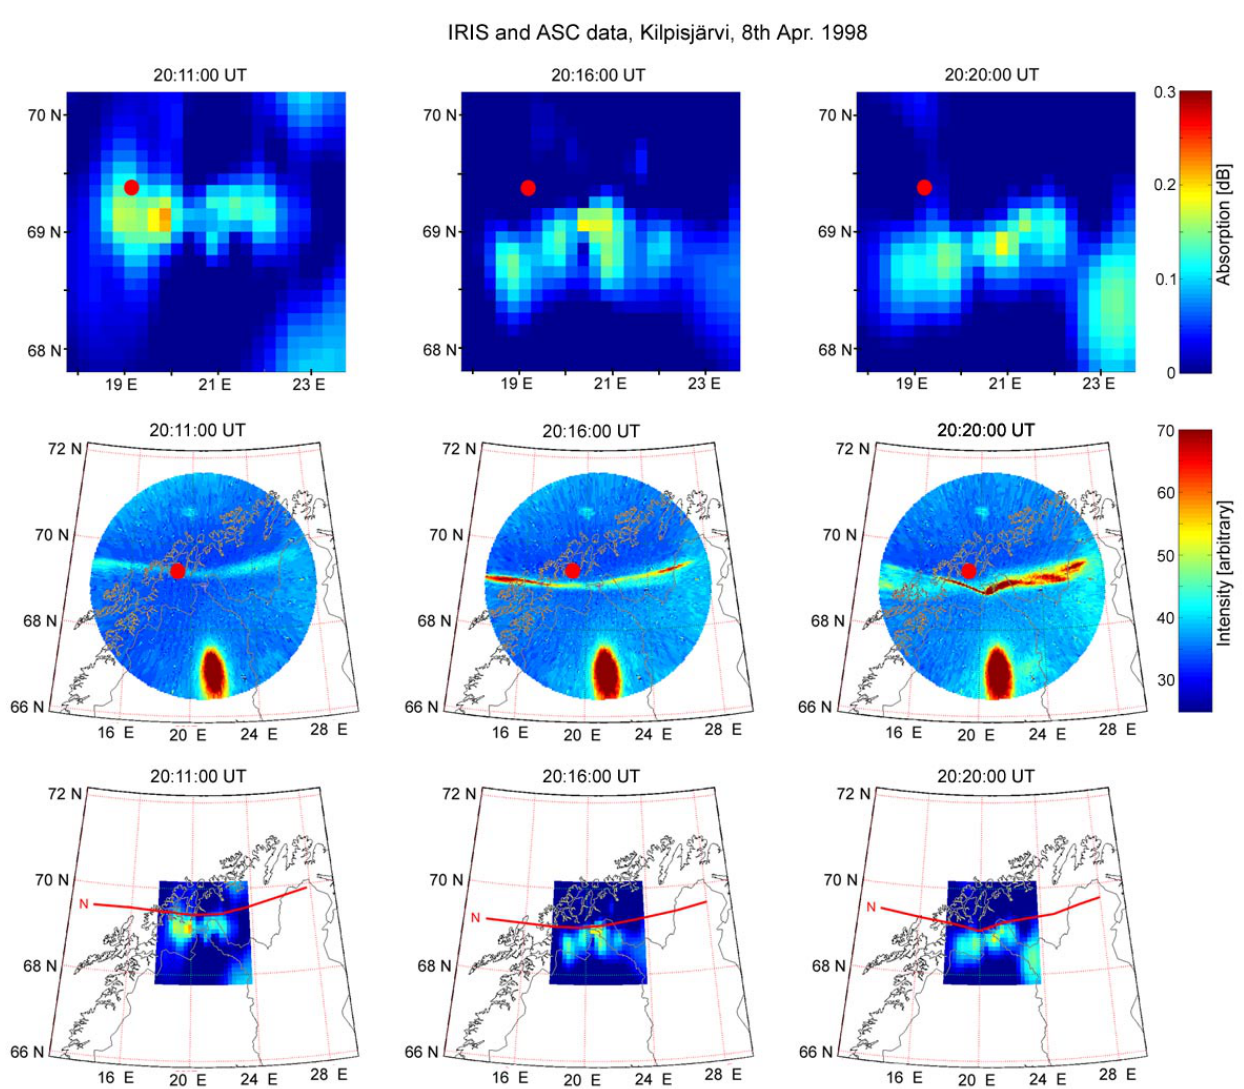
Fig. 5. Absorption, optical and combined data from three times for Event 2 on 8 April 1998. The top panel shows the colour coded absorption from IRIS mapped to the longitude-latitude grid to the 80km altitude. The maximum value of absorption is 0.3dB. The middle panel shows the whole ASC image in false colour, mapped to the longitude-latitude grid at 120km height. The auroral intensities are arbitrary and scaled from the original 8-bit gray scale image. The bright red spot on the lower part of the images is the full Moon. The bottom panel shows the combined IRIS and ASC